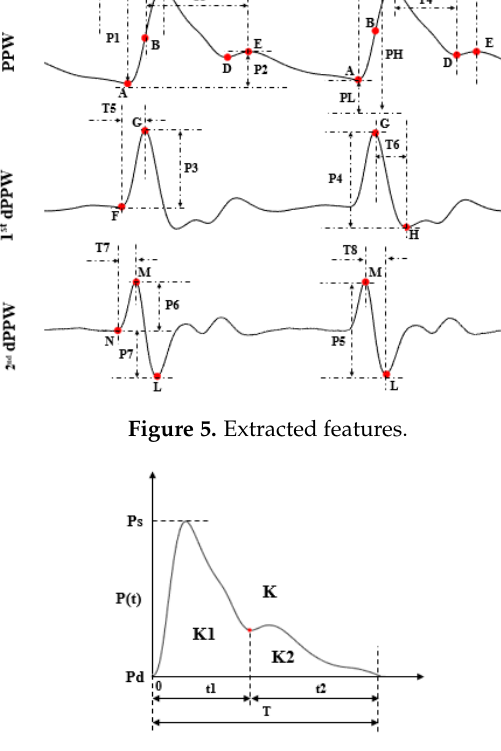
Figure 6. Definition of K-value in PPW.